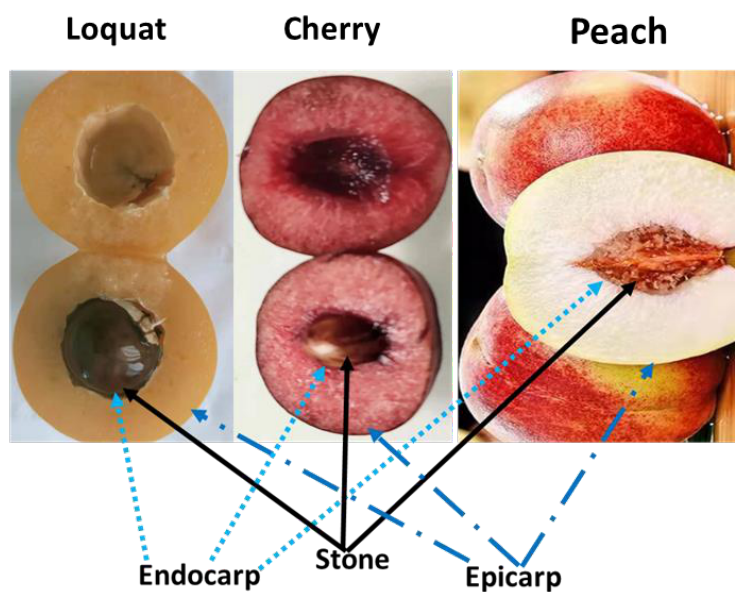
Figure 1. The fruit of loquat, cherry, and peach show their different parts: epicarp, endocarp, and stone .